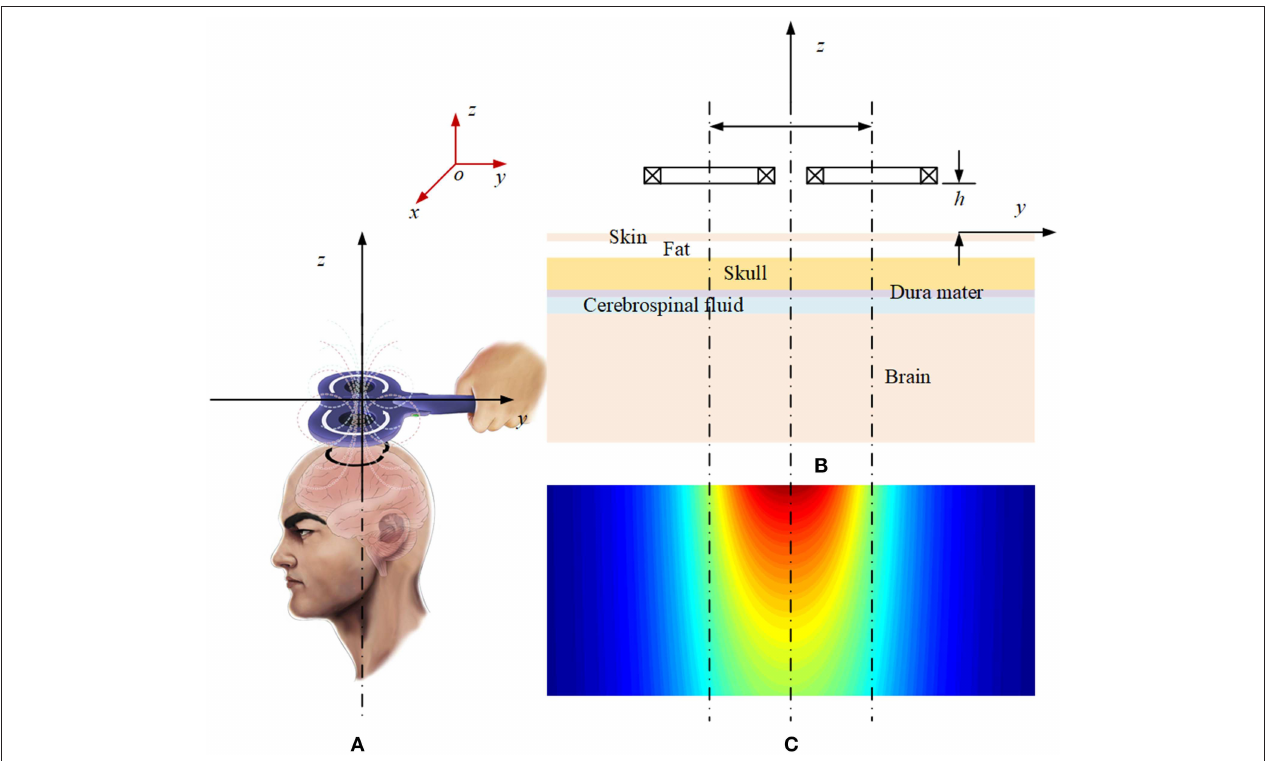
FIGURE 1 | Schematic diagram of the layered plane brain model: (A) Magnetic field of the rTMS coil. (B) Profile of the layered brain model and the coils. (C) Magnetic field distribution on the profile plane.